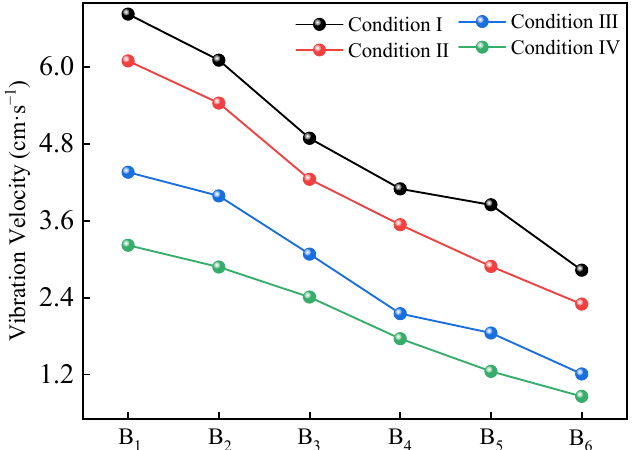
Figure 11. The feature points B 1 –B 6 .